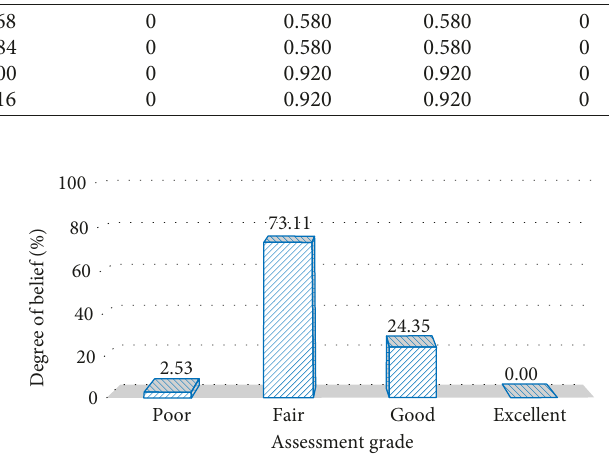
Figure 3: Overall condition assessment of the piers element of the substructure bridge